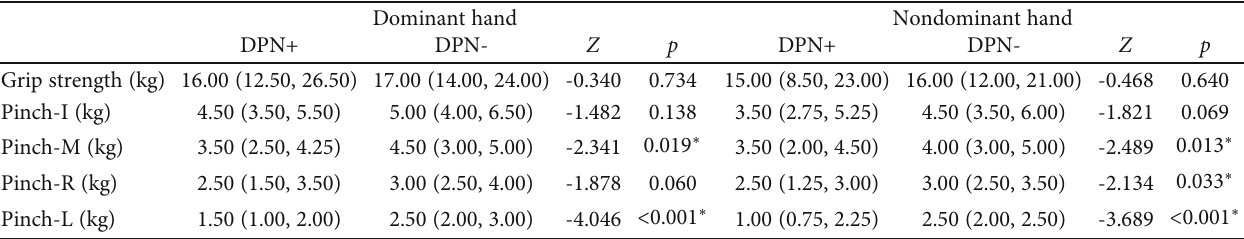
Table 3: Comparison of grip and pinch strength between the two